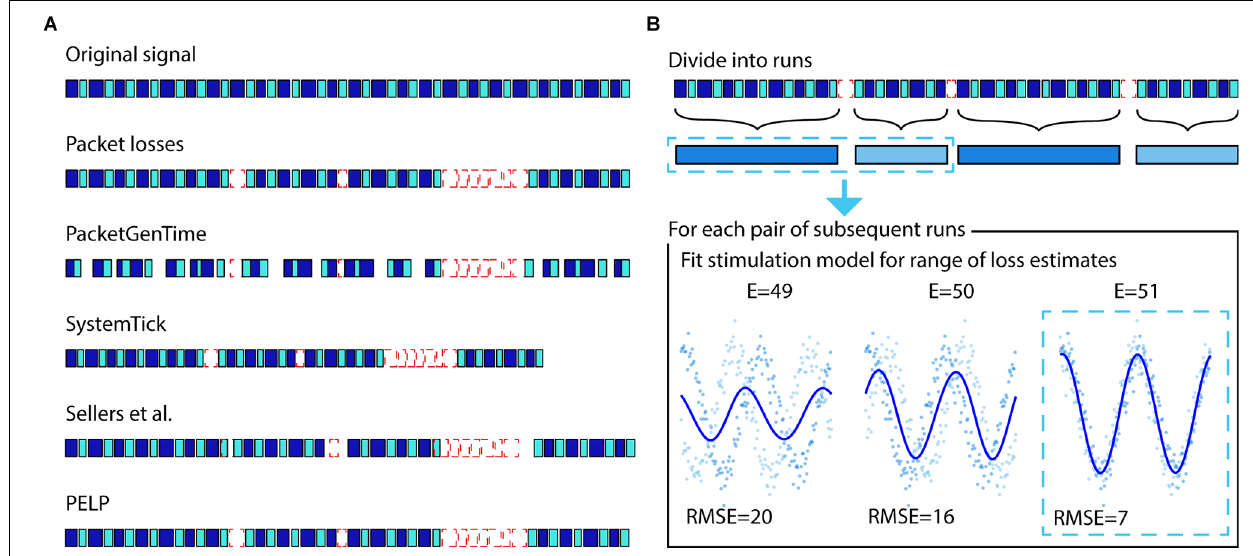
FIGURE 2 | Illustration of packet loss correction and PELP. (A) The relative timing of the samples contained in received packets can be uncertain. Adjusting timing solely with PacketGenTime leads to many inaccurate overlaps, systemTicks will accumulate error over long recordings, the approach from Sellers et al. (2021) ensures consistency within runs but offsets at losses, while PELP can ensure exact reconstruction. (B) PELP begins by grouping contiguous packets (blue, first row) into continuous runs (blue, second row) where each run is separated from adjacent runs by losses (dashed-red). Loss sizes are estimated but uncertain. The stimulation period is analytically determined using all the data. For each pair of subsequent runs, the root mean squared error (RMSE) between a stimulation model and the samples in the two runs is computed for a range of loss sizes centered around the estimate (indicated by E = for each size). A new stimulation model is fit for each loss estimate. The loss size that minimizes the RMSE is selected as the true loss